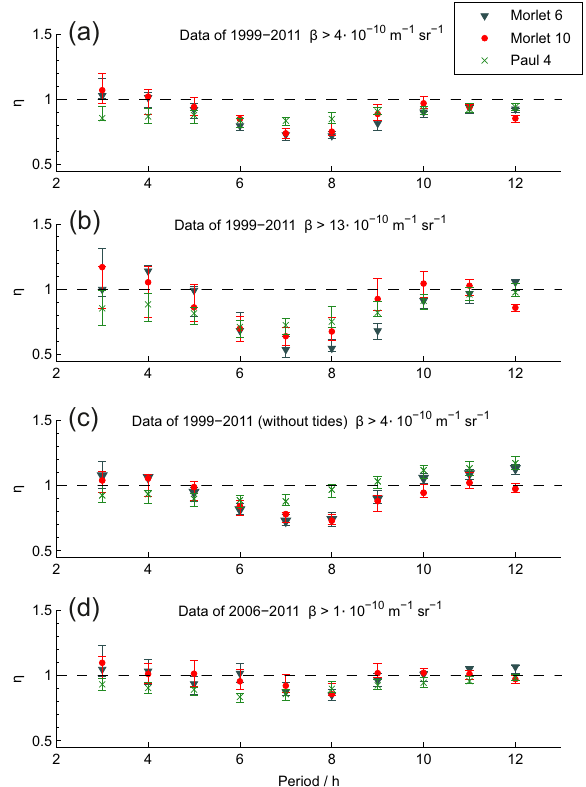
Fig. 9. (a) Ratio η as in Fig. 5 for the combined dataset of 1999– 2011 for β max > 4 × 10 − 10 m − 1 sr − 1 (long-term detection limit) and (b) for strong NLC with β max > 13 × 10 − 10 m − 1 sr − 1 . (c) Ra- tio η as in panel a for the combined dataset of 1999–2011 where the tidal components of the wind have been removed. (d) Ratio η for the combined dataset of 2006–2011 with NLC detection limit of β max = 1 × 10 − 10 m − 1 sr − 1 (high-sensitivity